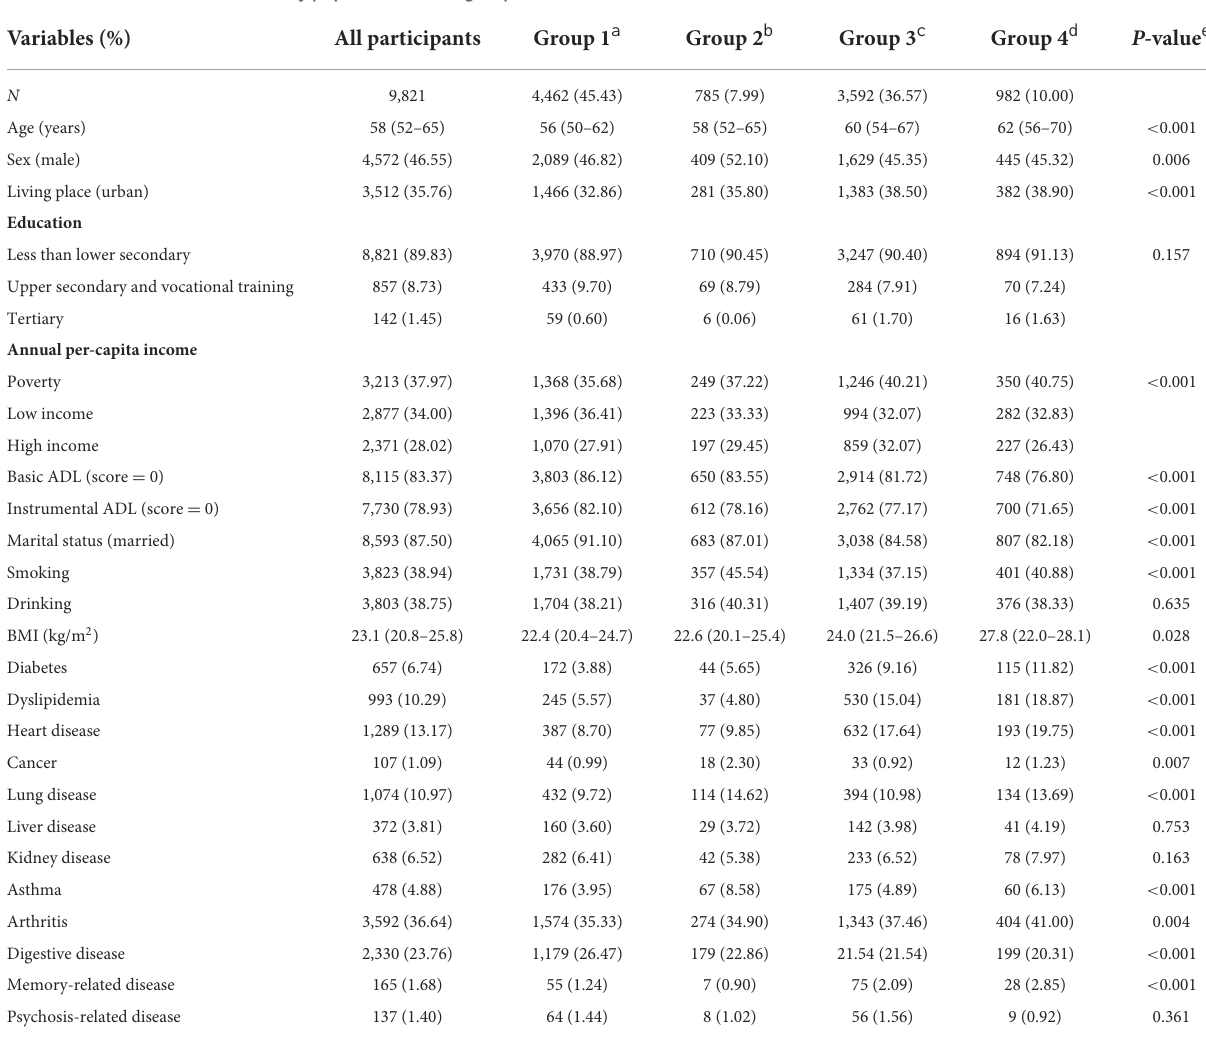
TABLE 1 Characteristics of the study population in four groups in